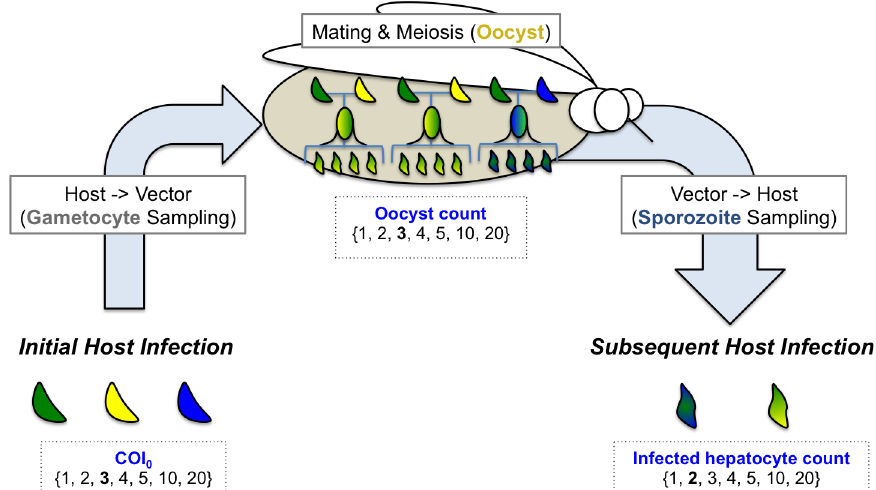
Fig 3. Model of parasite transmission. Model of transmission where genetically distinct parasites are distinguished by color. Parameter values are drawn from the set {1, 2, 3, 4, 5, 10, 20}, which represents the range of values observed in real life simulations. The bold number indicates the value in the example shown in the figure. Gametocytes are sampled from an initial polygenomic infection comprised of unrelated parasite strains. Sampled gametocytes are used to create oocysts within the mosquito midgut (middle). Each oocyst summarizes the entire sequence of events starting from gamete fusion to the end of meiosis. Oocysts are represented using a stylized pedigrees tree, where the crescents at the top represent parental strains undergoing meiosis, the oval in the center indicates whether the mating event is the result of selfing (solid color) or outcrossing (color-gradient), and the sporozoites at the bottom represent the four meiotic products generated through meiosis. Those with multiple colors indicate that genomes have undergone effective recombination and are genetically distinct from the parental strains and to each other. Sporozoites are sampled from the total pool of meiotic products to determine the genetic composition of the subsequent host infection. The number of sporozoites sampled is determined by the infected hepatocyte count used in the simulation.